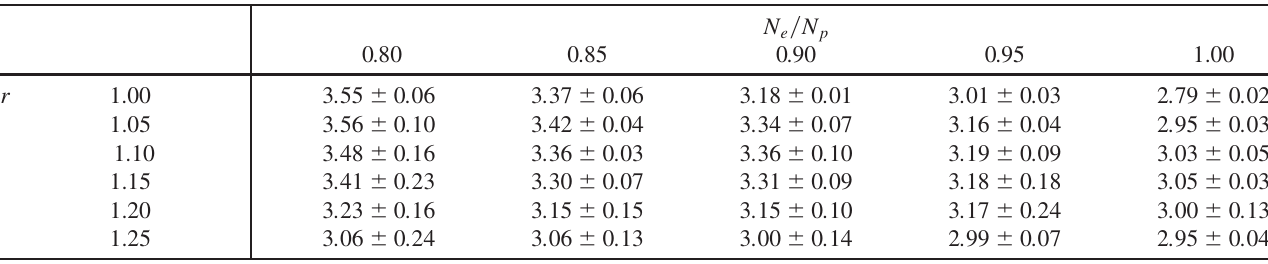
TABLE III. Normalized luminosity L in units of 10 11 as a function of intensity ratio N e =N p and the beam size ratio r ¼ r x ¼ norm =(cid:6) ¼ r ¼ (cid:6) =(cid:6) e ’’ refers to the electron lens beam, while the subscript ‘‘ p ’’ corresponds to the proton (cid:6) x;e x;p y y;e y;p . The subscript ‘‘ beam. Since we deliberately chose the same beta-functions at both the IP and the electron lens, equal beam sizes (cid:6) x;e ¼ (cid:6) x;p , (cid:6) y;e ¼ (cid:6) N ¼ N y;p and intensities e p correspond to the case of full beam-beam